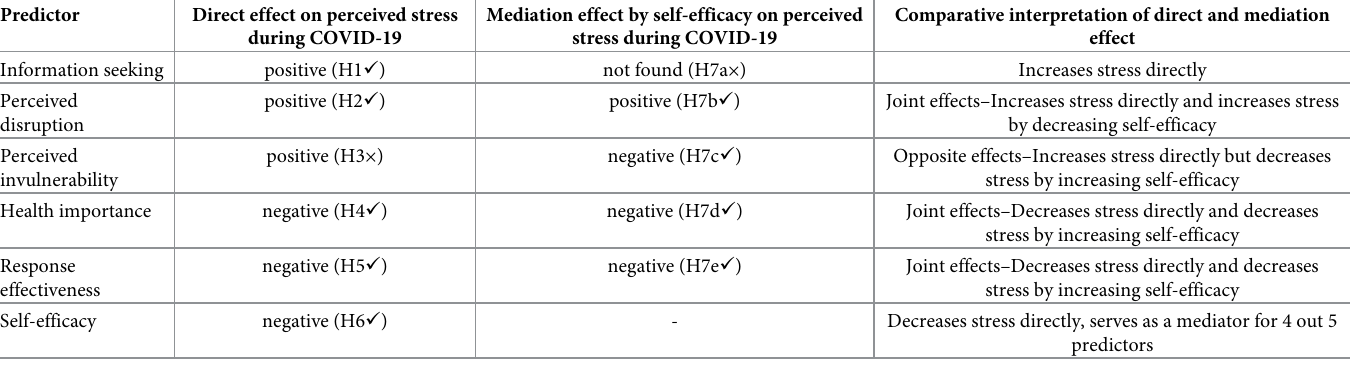
Table 4. Comparison of direct and mediation effects for the predictors of perceived stress.